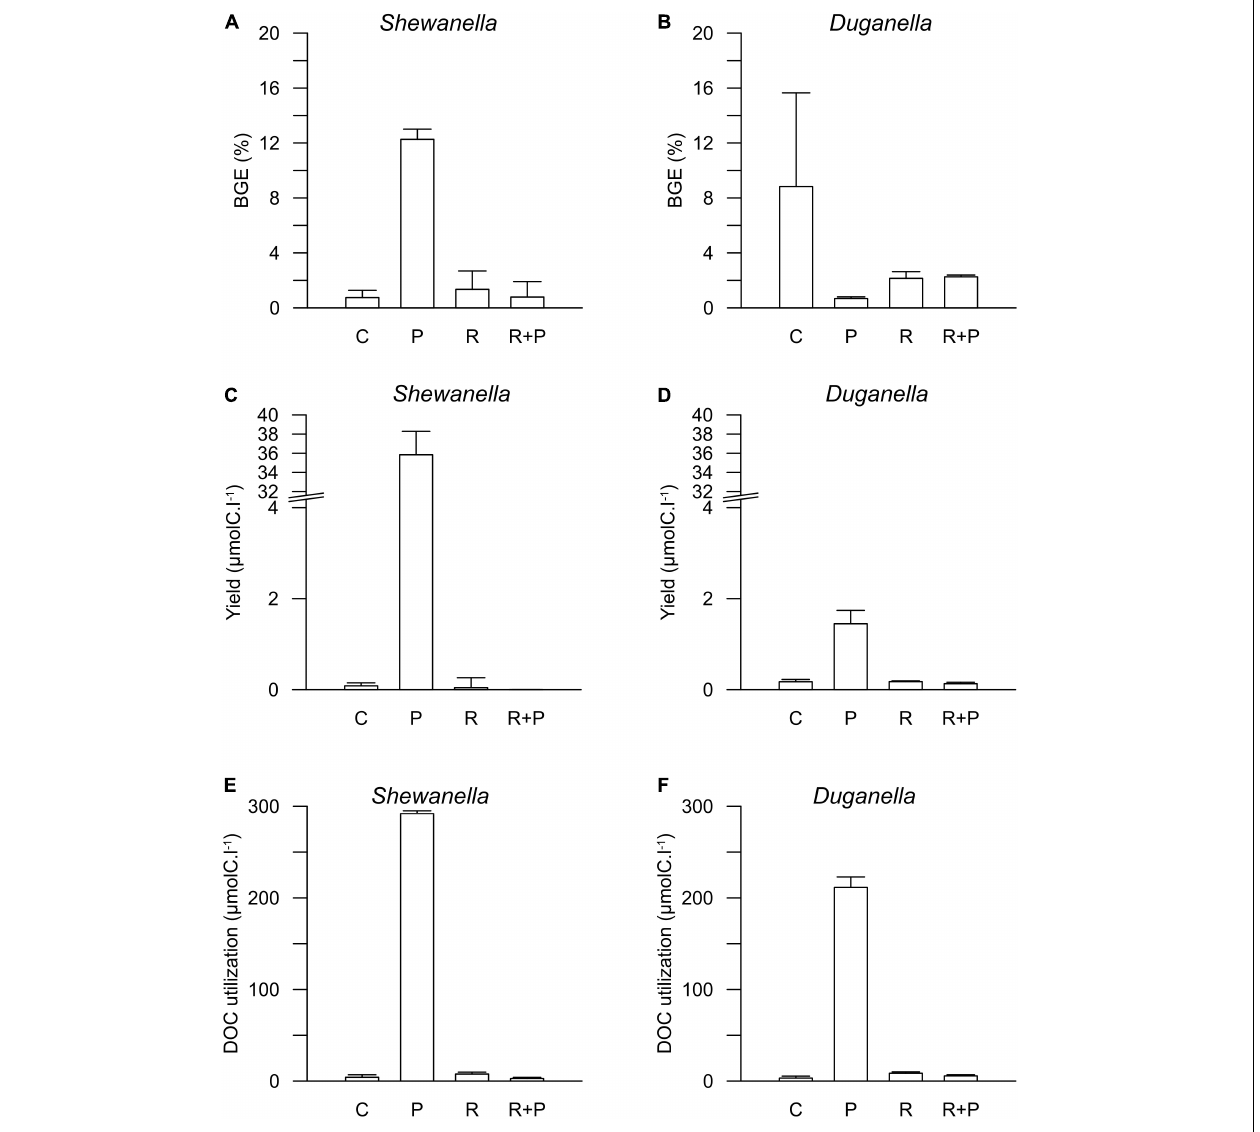
FIGURE 4 | Bacterial growth efficiency (BGE) in (A) Shewanella and (B) Duganella incubations, bacterial biomass yield in (C) Shewanella and (D) Duganella incubations, and DOC utilization in (E) Shewanella and (F) Duganella incubations. C = control; P = plankton extract; R = river extract; R + P = river extract supplemented with phosphorus. Bar graphs show average values, and error bars denote standard